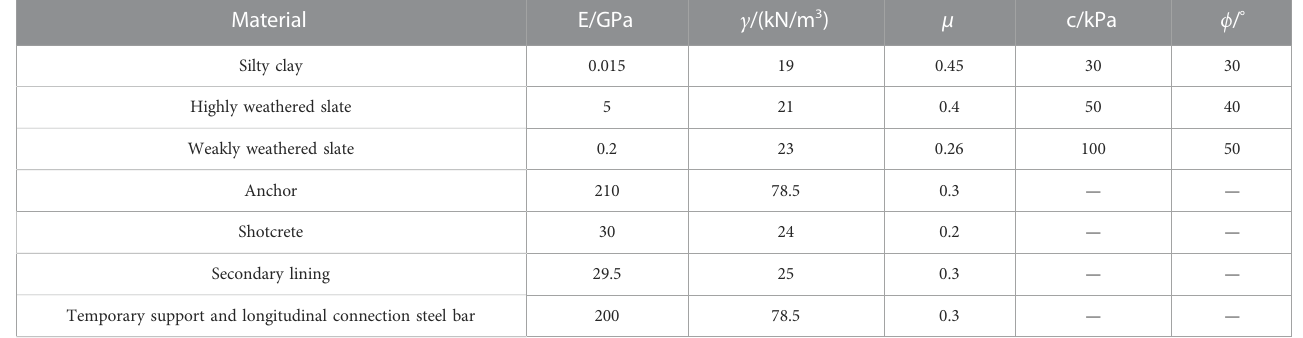
Temporary support and longitudinal connection steel